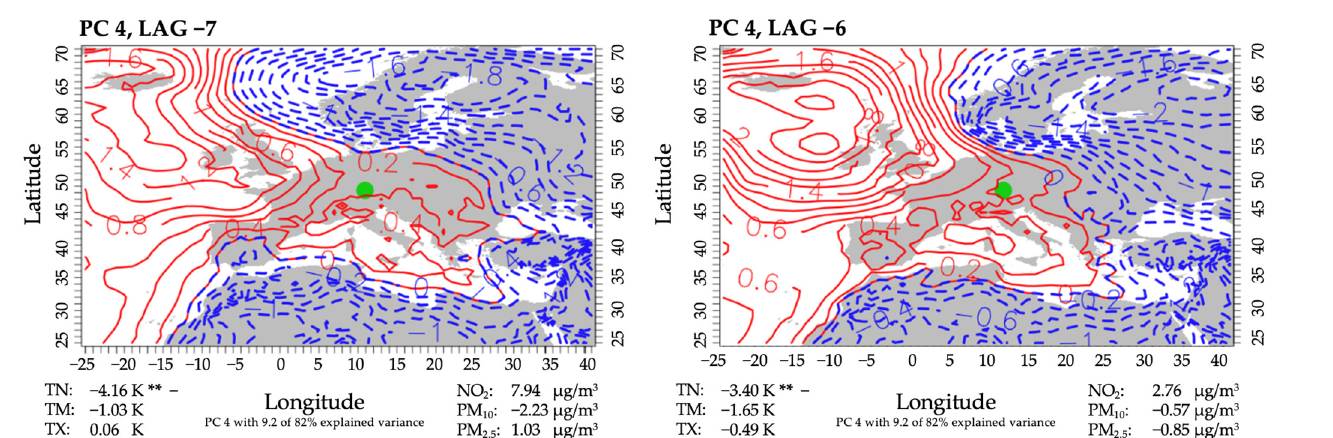
Figure 6. Same as Figure 4, but for PC 4. The level of significance is provided (**: 0.05; *: 0.1). The mean difference of all days of the same lag minus the mean of all non-high-mortality-related days, indicated by + or − . + indicates a higher anomaly mean on the corresponding lag days than on non-high-mortality-related days. − indicates a lower anomaly mean on the corresponding lag days than on non-high-mortality-related